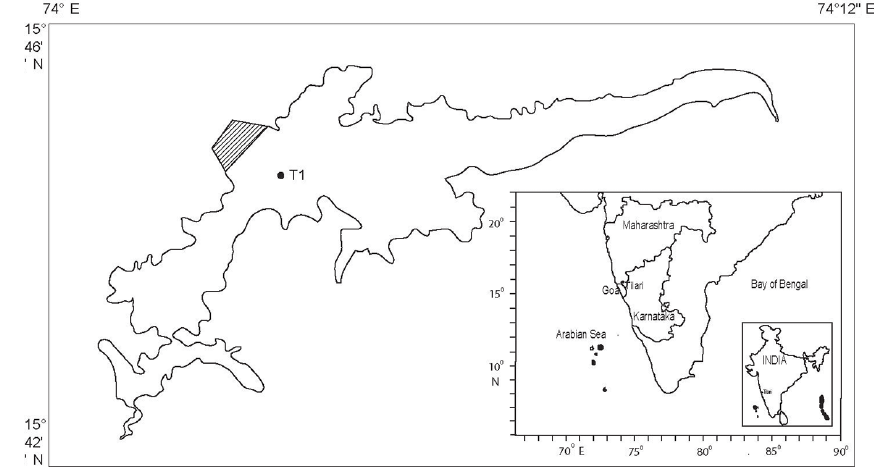
Figure 1. Map of the sampling location (Tillari Reservoir). T1 shows the main sampling location at the deepest point of the reservoir.